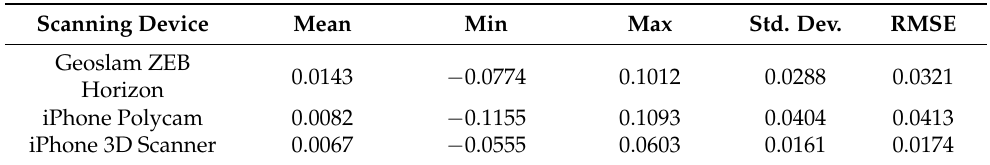
Table 4. Statistical evaluation of accuracy—height differences of points from transverse profiles in comparison with TLS scanner Faro Focus 3D.